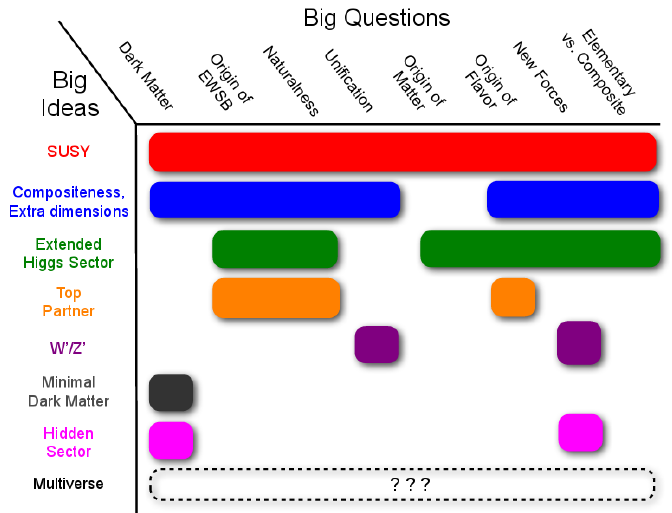
Figure 11. Various problems of the standard model and some theoretical proposals trying to solve them [23]. EWSB: electroweak symmetry